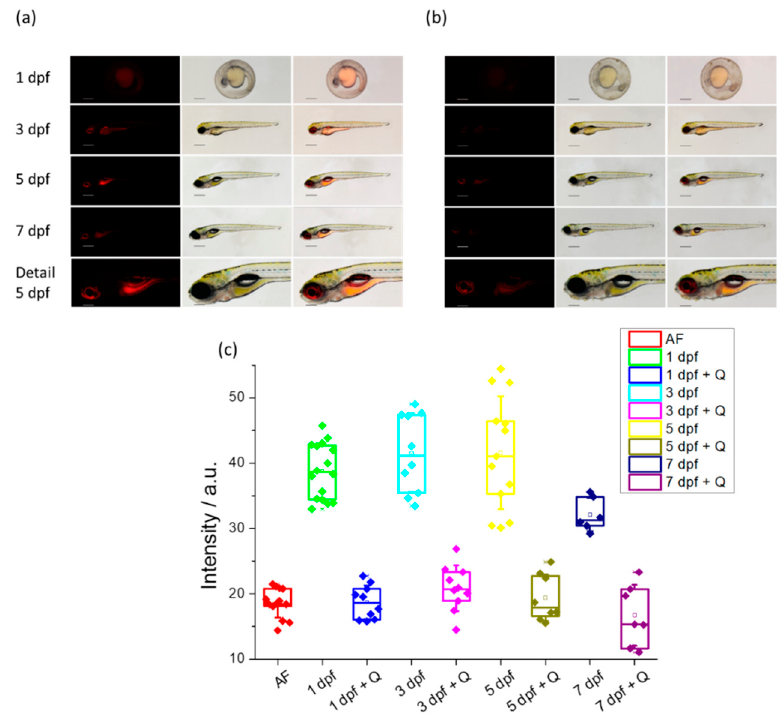
Figure 8. ( a ) Living zebrafish embryos and larvae incubated with DCM-HBU (10 µ M) for 3 h at different developmental stages (1, 3, 5, and 7 dpf); red fluorescent (left), brightfield (centre), and merge (right) images were taken by a stereo microscope ( λ ex = 458 nm, λ em = 680 nm). Detail (head with central nervous system) of a living zebrafish larva at 5 dpf is also shown. Scale bars: 1 dpf: 250 μ m, 3–7 dpf: 500 μ m, detail: 200 μ m. ( b ) Living zebrafish embryos and larvae at the same dpf pre-incubated for 3 h with 200 μ M quercetin and incubated with 10 μ M DCM-HBU for 3 h. ( c ) Intensity values of NIR emission of zebrafish at different dpf, incubated with 10 μ M DCM-HBU in presence or absence of the inhibitor quercetin. Boxes represent the 25th, 50 th , and 75th percentiles. Whiskers represent the SE.